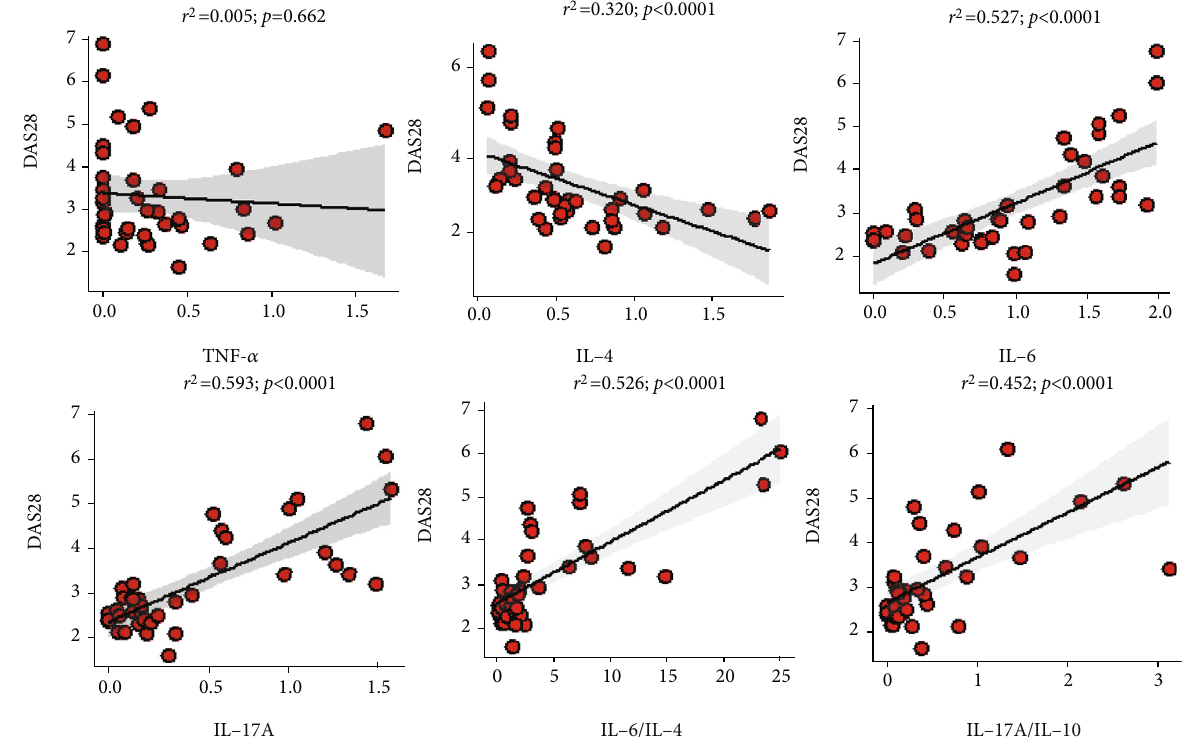
Figure 3: Linear relationship between T cell cytokines and their ratios and DAS28 scores among RA